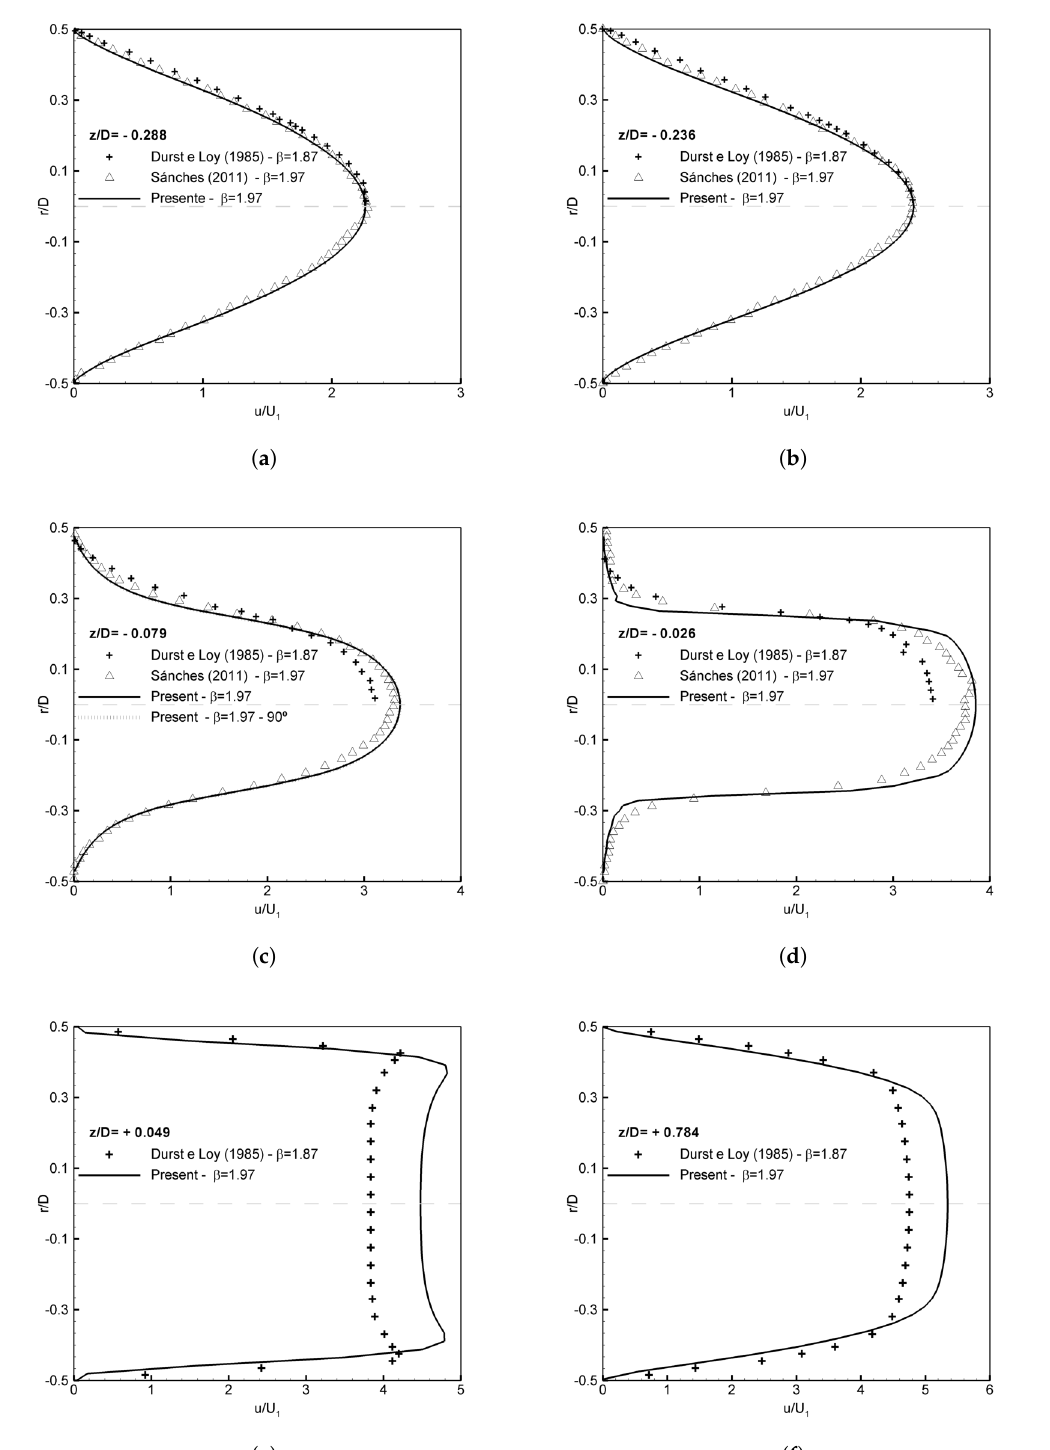
Figure 8. Comparison of numerical and experimental non-dimensional axial velocity profiles for Re D = 365 ( a ) z / D = − 0.288, ( b ) z / D = − 0.236, ( c ) z / D = − 0.079, ( d ) z / D = − 0.026, ( e ) z / D = + 0.049 and ( f ) z / D = +